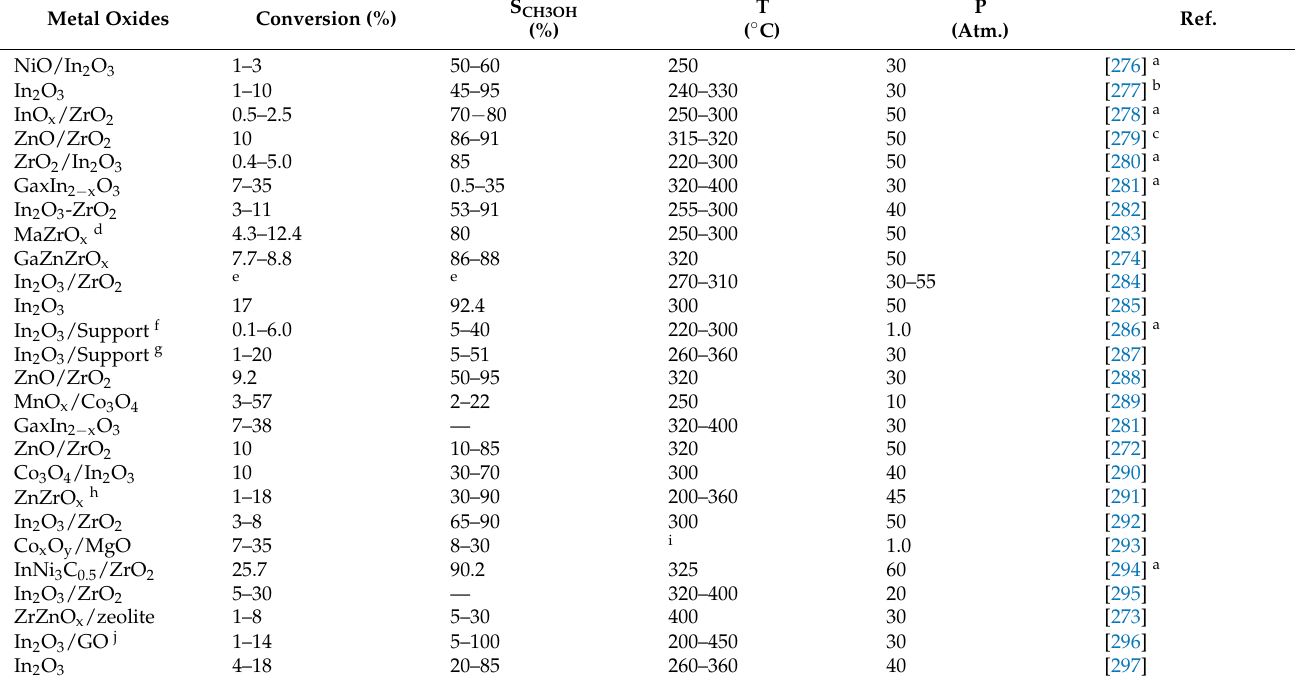
Table 8. A comparative summary of different active metal oxides catalysts studied in the carbon dioxide hydrogenation process to obtain